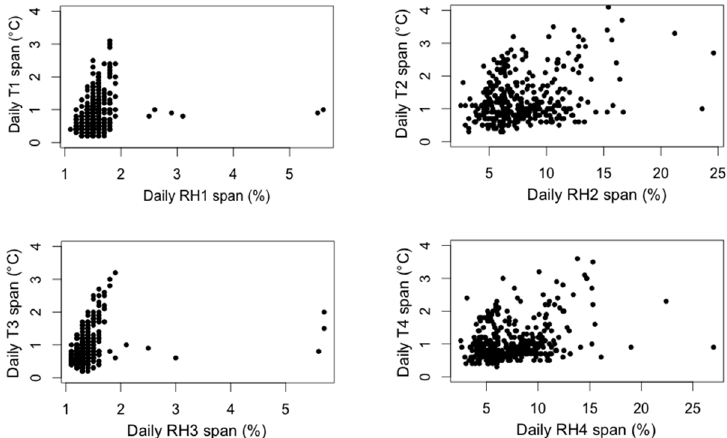
Figure 4. Scatter diagram of daily RH span versus daily T span inside (probes 1 and 3) and outside (probes 2 and 4) the microclimate frames. The daily span is calculated as the difference between the maximum and minimum values of each day.